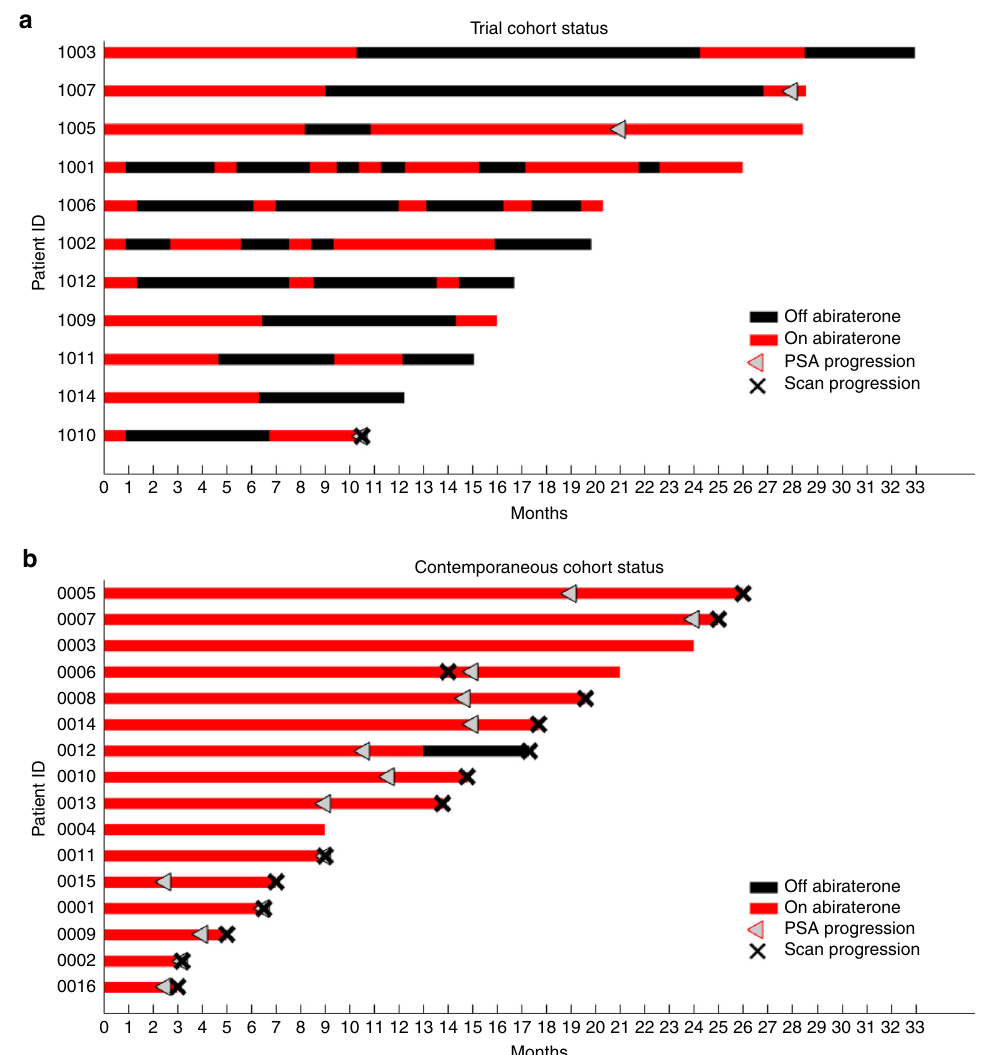
Fig. 5 A summary of the status of the 11 patients in the pilot trial ( a ) and 16 patients in the contemporaneous cohort ( b ). In the SOC group, 14 of 16 have progressed radiographically compared to 1 of 11 in the adaptive therapy cohort. Cumulative dose of abiraterone in the adaptive therapy patients was 47%